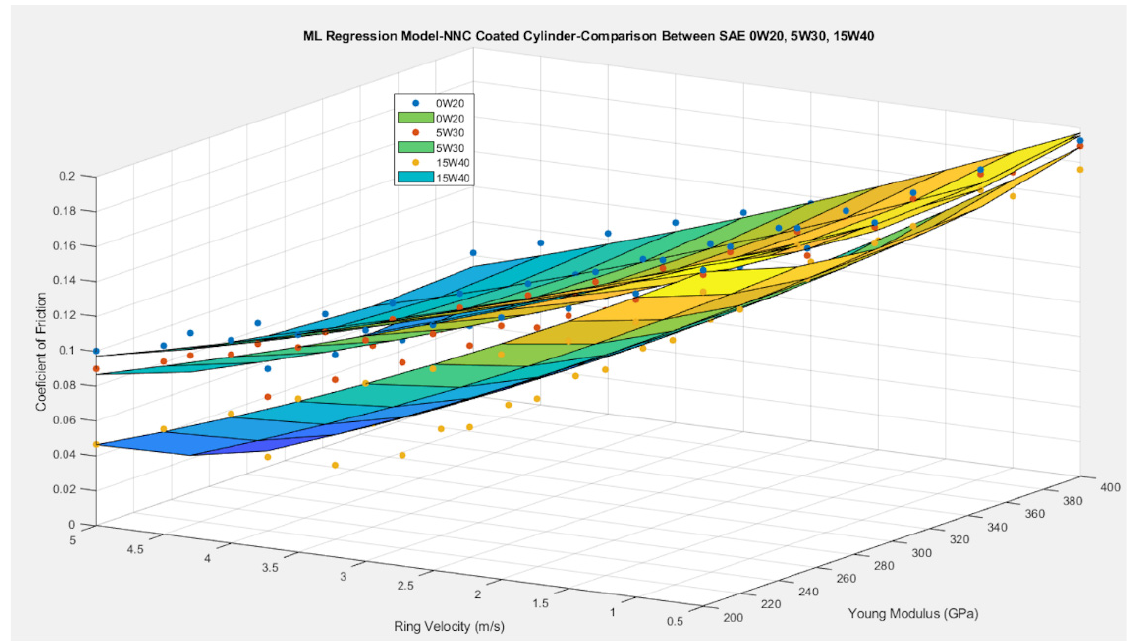
Figure 6. Multi-variable 2nd-order polynomial regression model comparison between SAE 0W20, SAE 5W30, and SAE 15W40 for coated piston rings with an NNC cylinder liner.